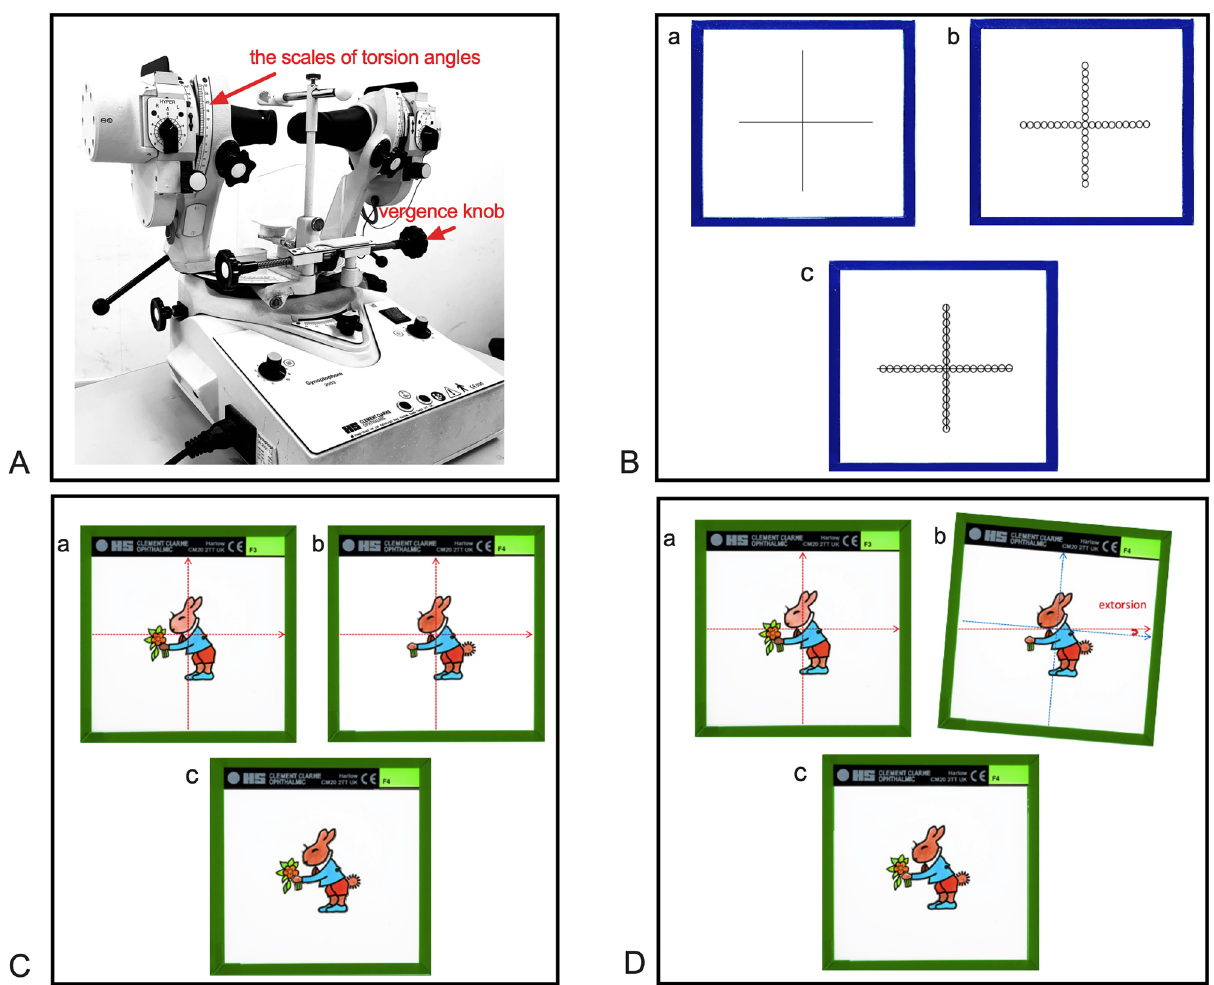
Figure 1. The steps of assessing fusion amplitude by synoptophore. ( A ) The scales of torsional angles and vergence knob showing in the picture of synoptophore. ( B ) The original objective deviation and torsion were determined by a pair of synoptophore "cross" slides. (a) the image presenting to the righ eye; (b) the image presenting to the left eye; (c) The subject pushes the rob till to gain the image of simultaneous perception. ( C ) A pair of fusion slides (11° slides) and fusion. (a) the image with one "control" presenting to the righ eye; (b) the similiar image with the other "control" presenting to the left eye; (c) The subject fuses and gains the single and complete image with two "controls" in the position of the original objective deviation. ( D ) A pair of fusion slides at a simulated torsional angle and fusion. (a) the image presenting to the righ eye; (b) the similiar image at a simulated extorsion angle presenting to the left eye; (c) the subject fuses and gains the single and complete